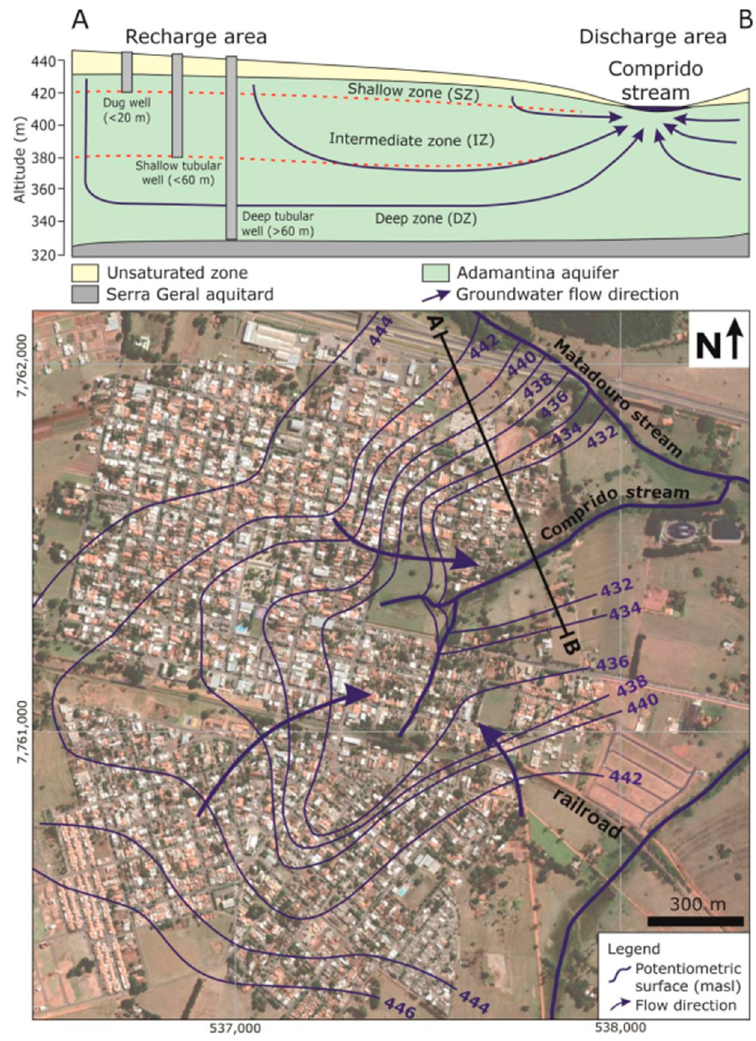
Figure 2. The Adamantina Aquifer’s potentiometric surface map and conceptual hydrogeology cross-section.